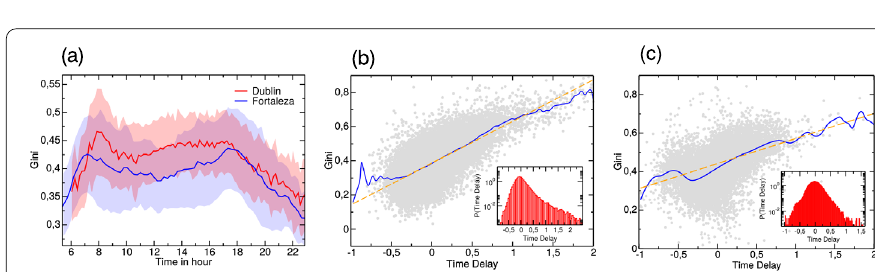
Figure 4 Gini coefficient by time of day and delay. ( a ) The variation of the Gini coefficient with time during the day. The continuous lines (blue for Fortaleza and red for Dublin) represent the average Gini ( μ gini ) for bins equally spaced for all trips of the workdays of a week in Fortaleza and Dublin. The shaded area around the average represents μ gini ± σ gini , in which σ gini is the standard deviation of the Gini for bins equally spaced. The plot corroborates the expectation that the largest values of Gini are in the rush hours. ( b ) The correlation between Gini coefficient and fraction of time delay for Fortaleza. Each point represents a trip and for each one a delay value D is calculated. The D measures the deviation of the expected value for the total time of that bus trip. The continuous line represents the Nadaraya–Watson non-parametric regression and the dashed line is the linear regression. The linear regression shows a relation of G = 0.38 + 0.24 ∗ D and the inset is the distribution of travel delay values. ( c ) The same correlation as ( b ) for Dublin. The linear regression shows a relation of G = 0.44 + 0.13 ∗ D and the inset is the distribution of travel delay values